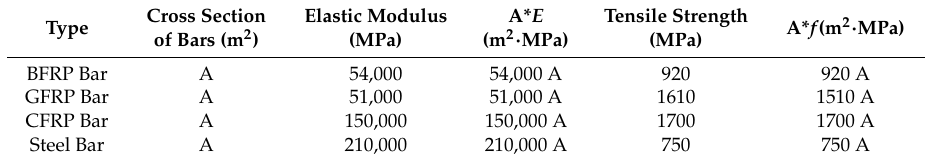
Figure 24. Influence of the reinforcement type on the ultimate bearing capacity. ( a ) Loading between the W-beams; ( b ) Loading between W-beams and W-beams. Table 4. Mechanical properties of different types of